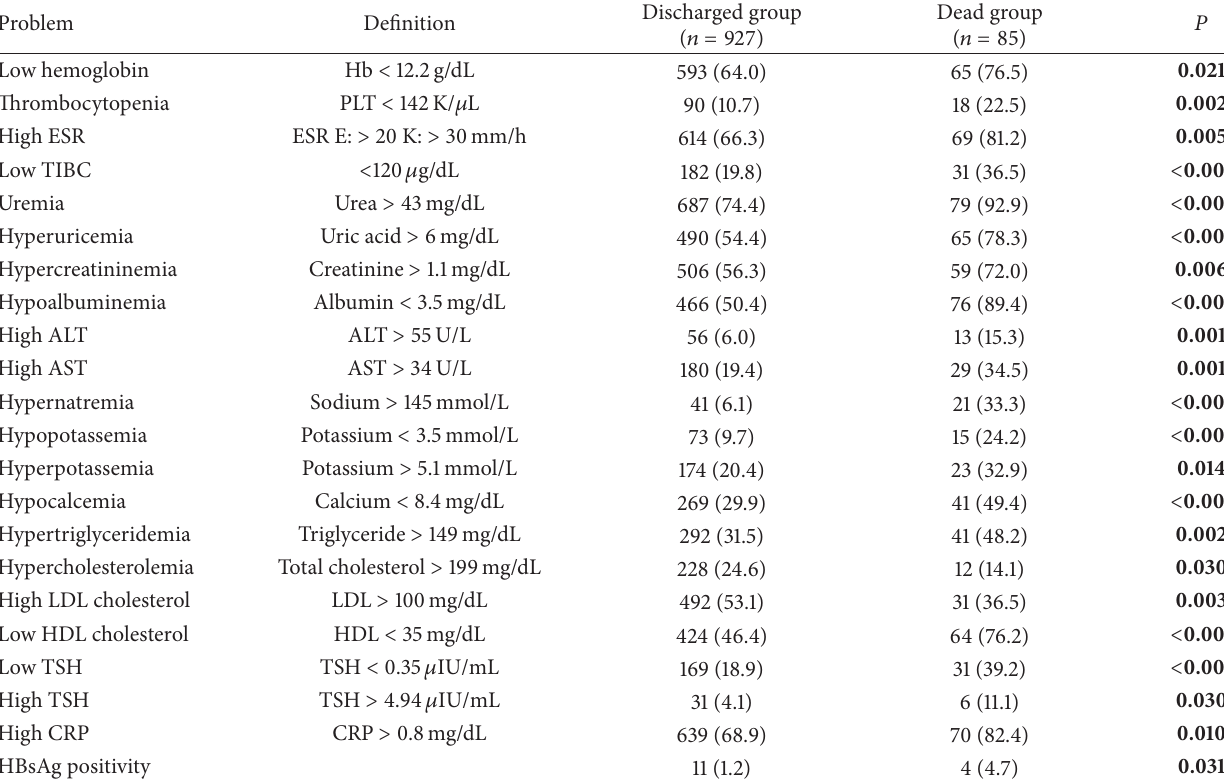
Table 4: Abnormal laboratory results at the time of hospitalization in the discharged and dead